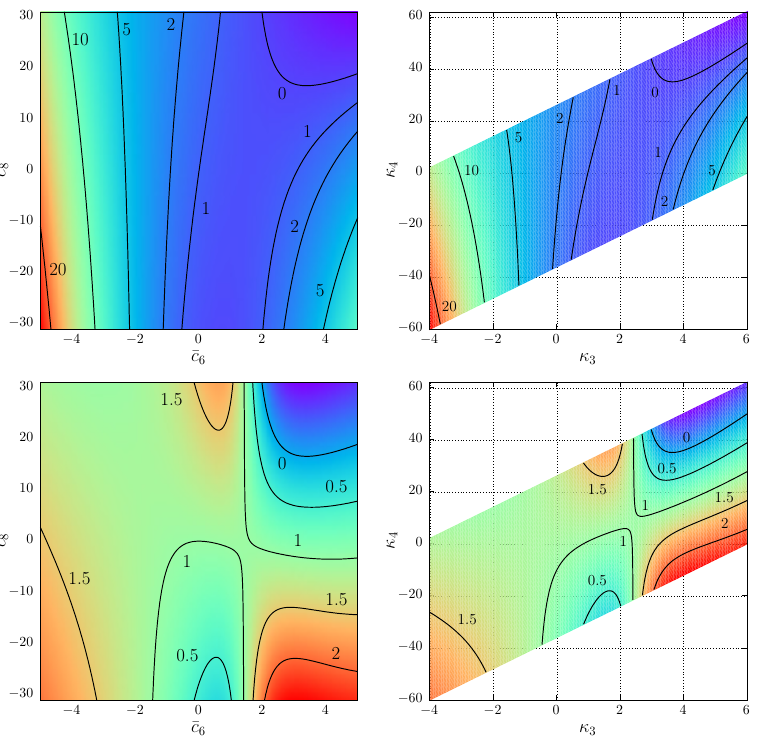
Figure 6 . Contour plots at 14 TeV for (cid:27) pheno show results in the ((cid:22) c 6 ,(cid:22) c 8 ) plane, while right plots in the ( (cid:20) 3 ; (cid:20) 4 ) plane.